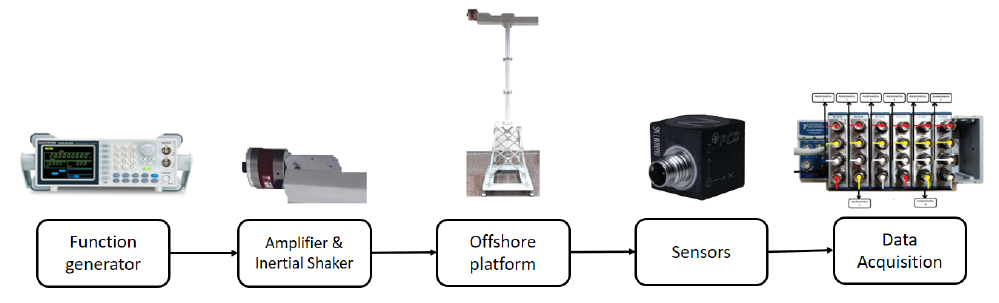
Figure 1. Experimental test bed.